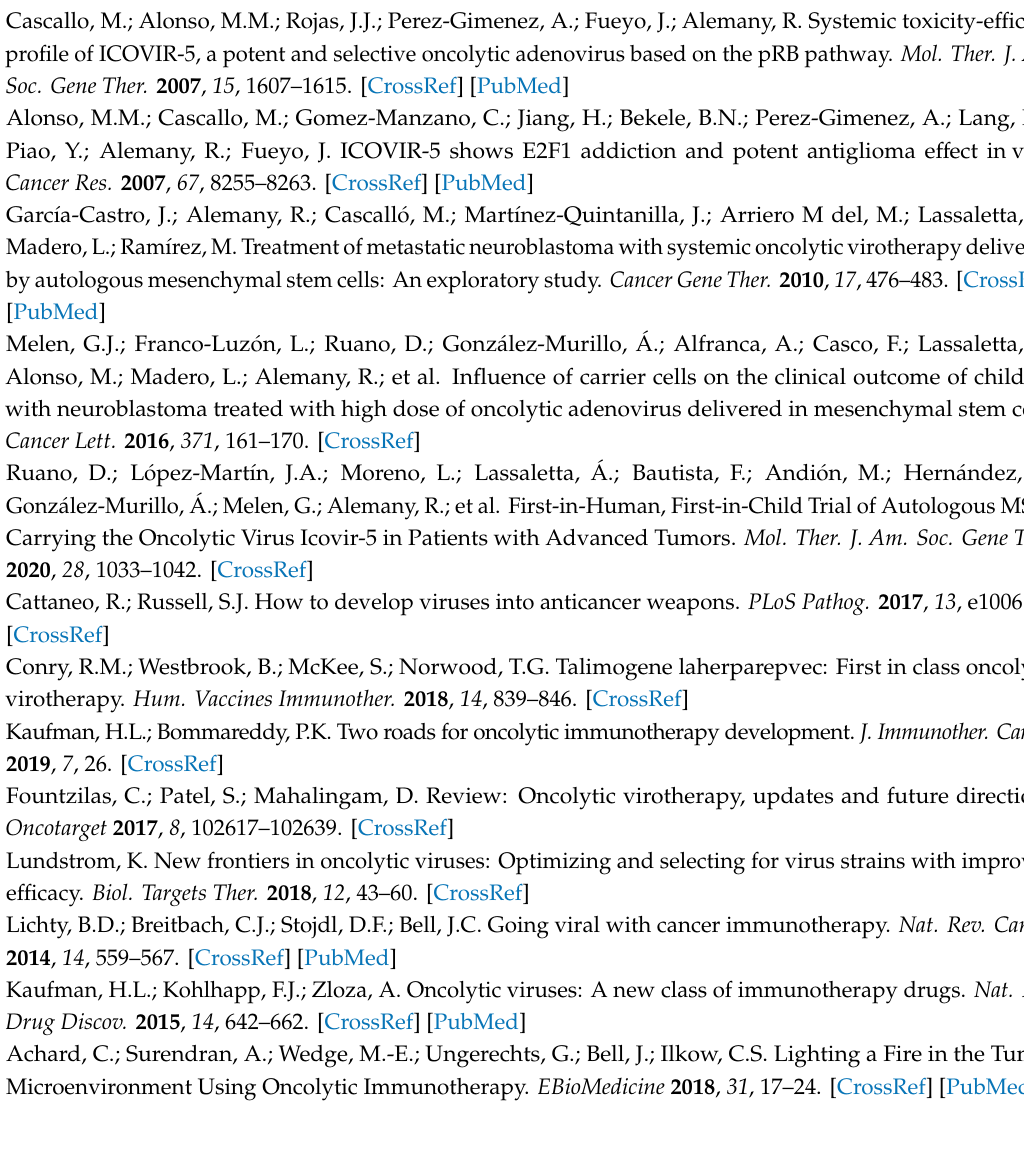
Figure S1: Immune phenotypes predicted by QuanTIseq for both disease stages; Figure S2: Genomic and molecular pathways and processes related to apoptosis and cell cycle for both disease stages, Table S1: Ten most common rearrangements for each tumor